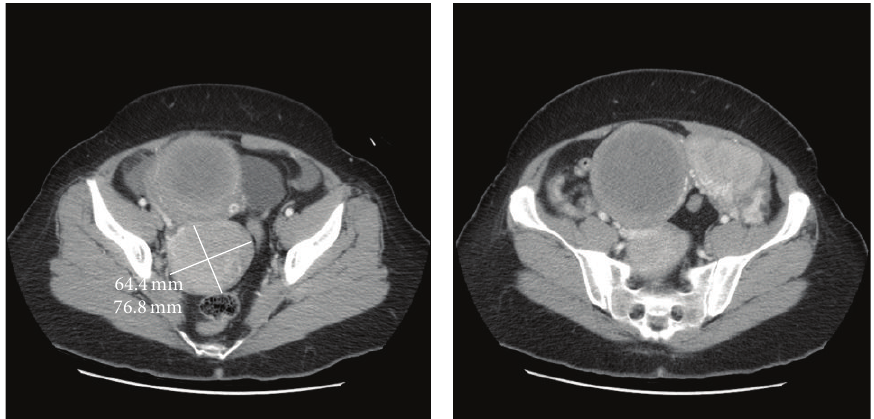
Figure 1: Representative computed tomography (CT) images of the abdomen and pelvis showing uLMS as a large heterogeneous uterine tumor.